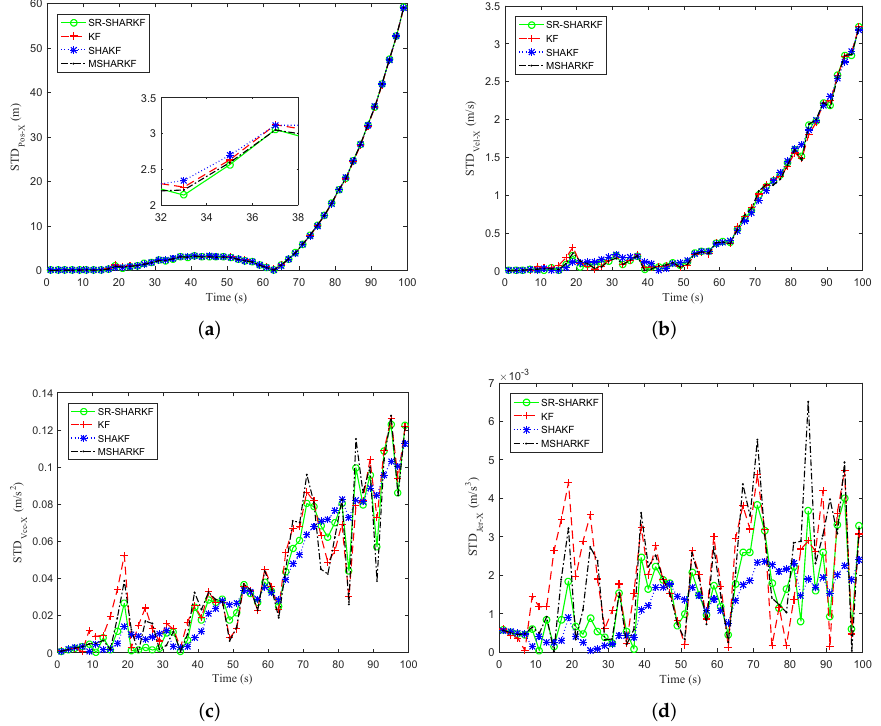
Figure 10. Dynamic parameter STD in the X-axis direction. ( a ) Position STD. ( b ) Velocity STD. ( c ) Acceleration STD. ( d ) Jerk